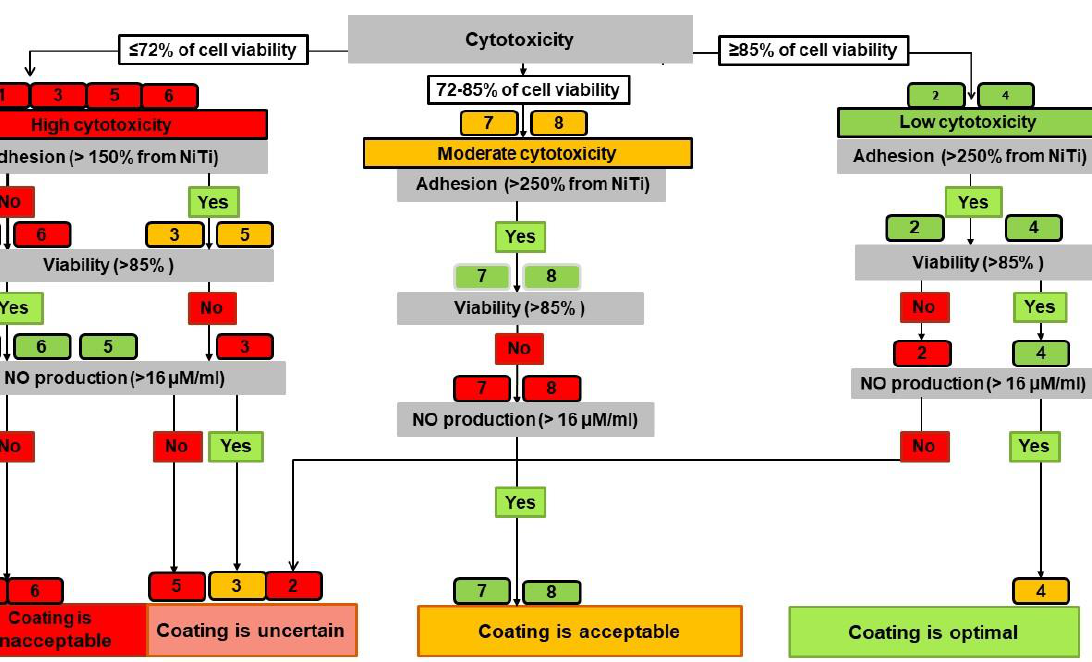
Table 4. The cytocompatibility scores of the TiO 2 and N-TiO 2 thin films.